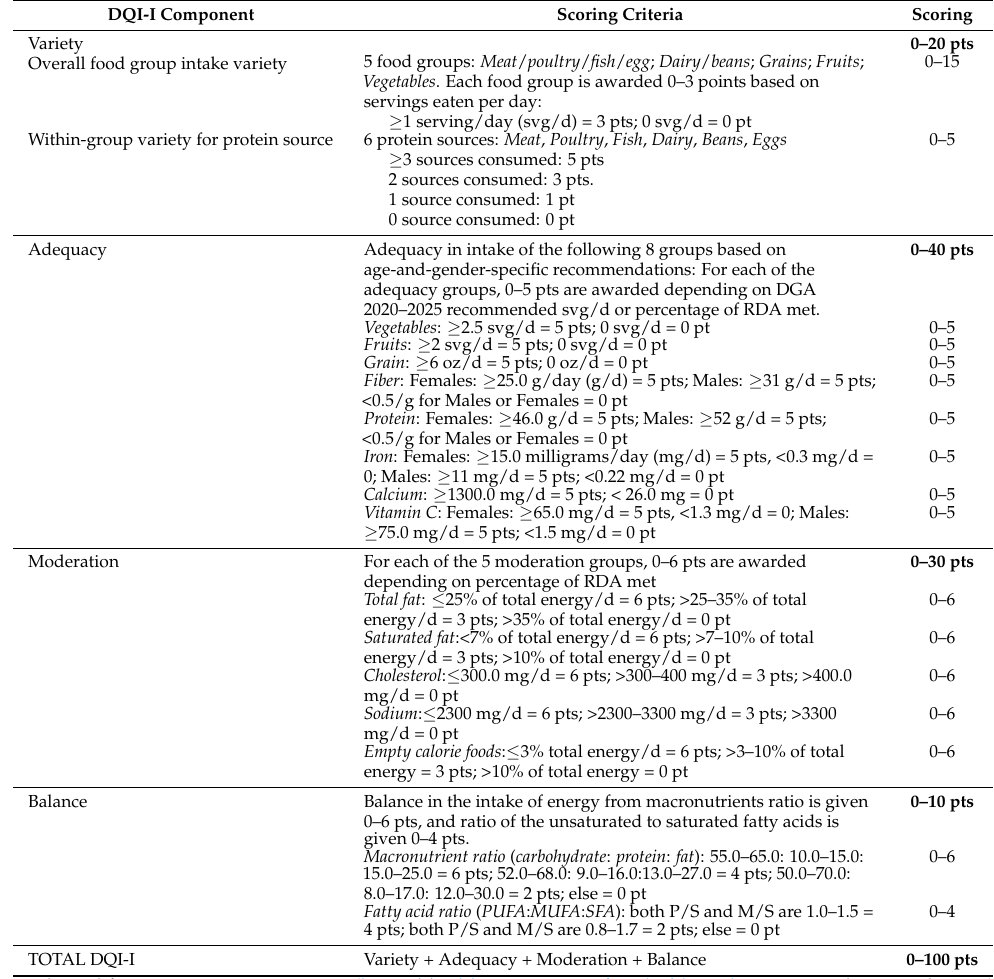
Table 1. Diet Quality Index—International (DQI-I) components and scoring system *. DQI-I Component Scoring Criteria Scoring Variety Overall food group intake